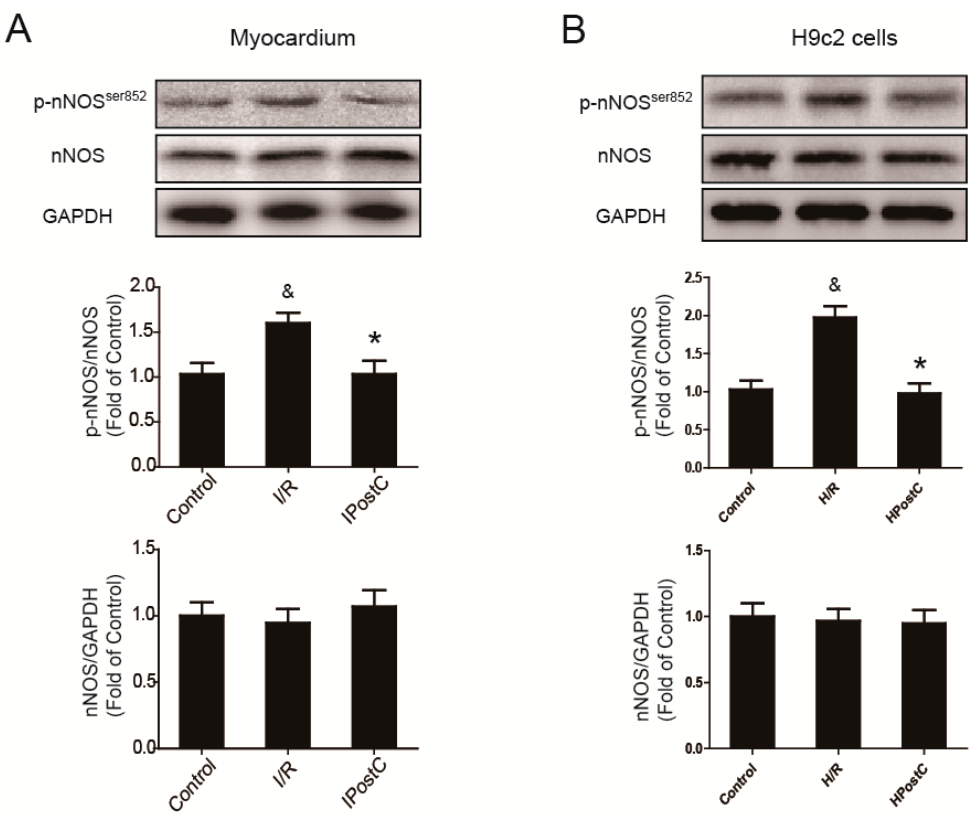
Figure 1. Activity of neuronal nitric oxide synthase (nNOS) was restored by ischemic postconditioning (IPostC) in the myocardium and H9c2 cells. ( A ) Expression of nNOS and nNOS Ser852 in the myocardium at 30 min of reperfusion; ( B ) The level of nNOS and nNOS Ser852 in H9c2 cells at 30 min of reoxygenation. & p < 0.05 versus control, * p < 0.05 versus ischemia/reperfusion (I/R). The mean values ± SEM, n = 6.